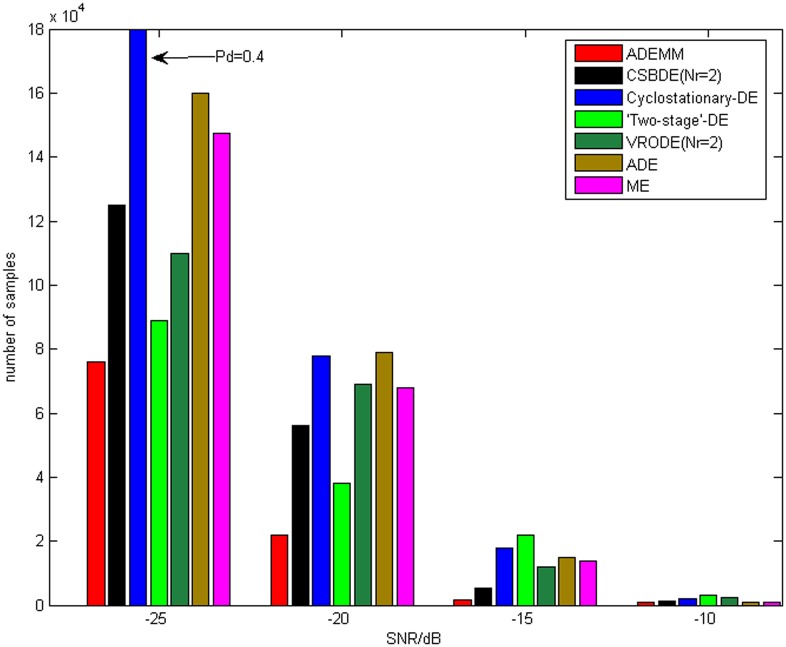
The required volume of samples (Pf = 0.1, Pd = 0.9).